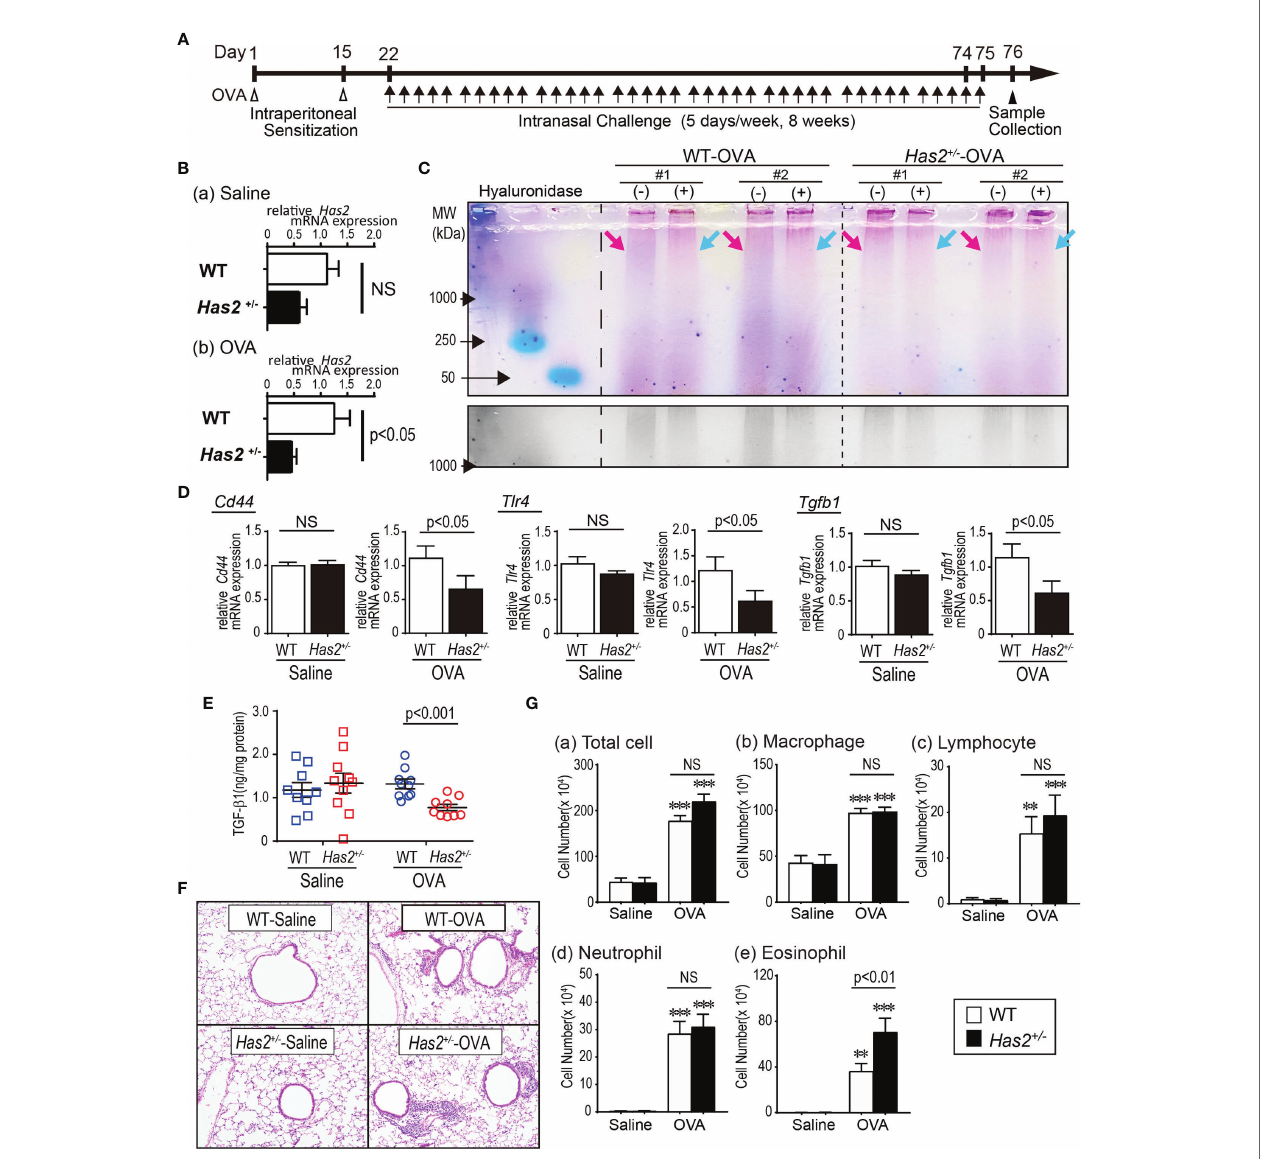
FIGURE 1 | Has2 attenuation downregulates the HMW-HA, HA-binding protein, and exacerbates airway in fl ammation in a chronic ovalbumin (OVA)-induced mouse model of asthma. (A) Schematic illustration of the experimental design. (B) Levels of mRNA transcripts encoding Has2 ( n = 6 – 9). (C) (Upper lane) HA size analysis with hyaluronidase treatment. (Lower lane) Grayscale in the high-molecular-weight area. (D) Levels of mRNA transcripts encoding Cd44, Tlr4 , and Tgfb1 ( n = 9 – 10). (E) Protein-adjusted levels of TGF- b 1 in lung homogenates ( n = 9 – 10). (F) Lung tissue HE staining. (G) BALF cytology of each indicated cell type ( n = 13 – 14). All samples are obtained 24 h after the fi nal challenge with saline or OVA. Statistical signi fi cance was determined using the Mann – Whitney U test (B, D, E) or Tukey ’ s multiple comparison test (G) . ** P < 0.01, *** P < 0.001 relative to the WT-saline control mice. Horizontal bars indicate direct statistical comparisons between WT and Has2 +/ − mice. NS, not signi fi